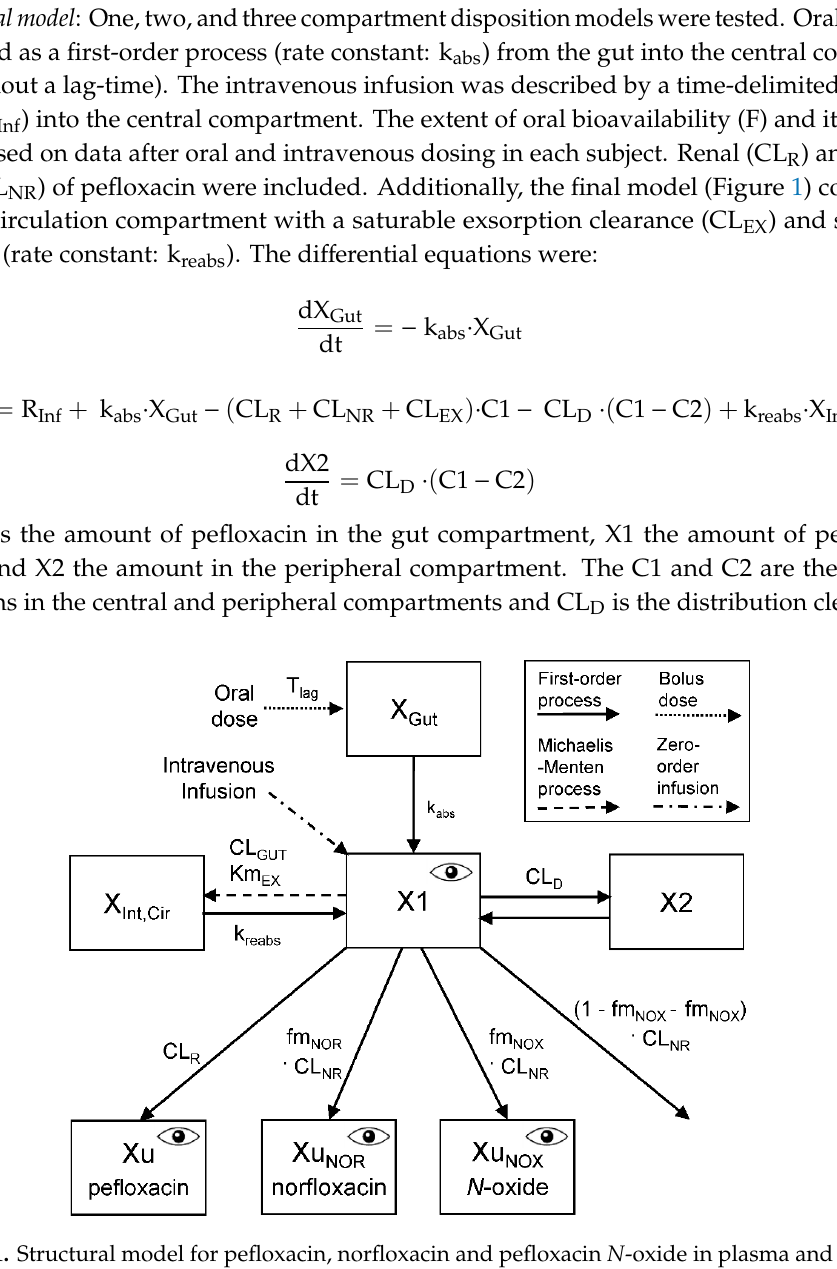
Figure 1. Structural model for pefloxacin, norfloxacin and pefloxacin N -oxide in plasma and urine.